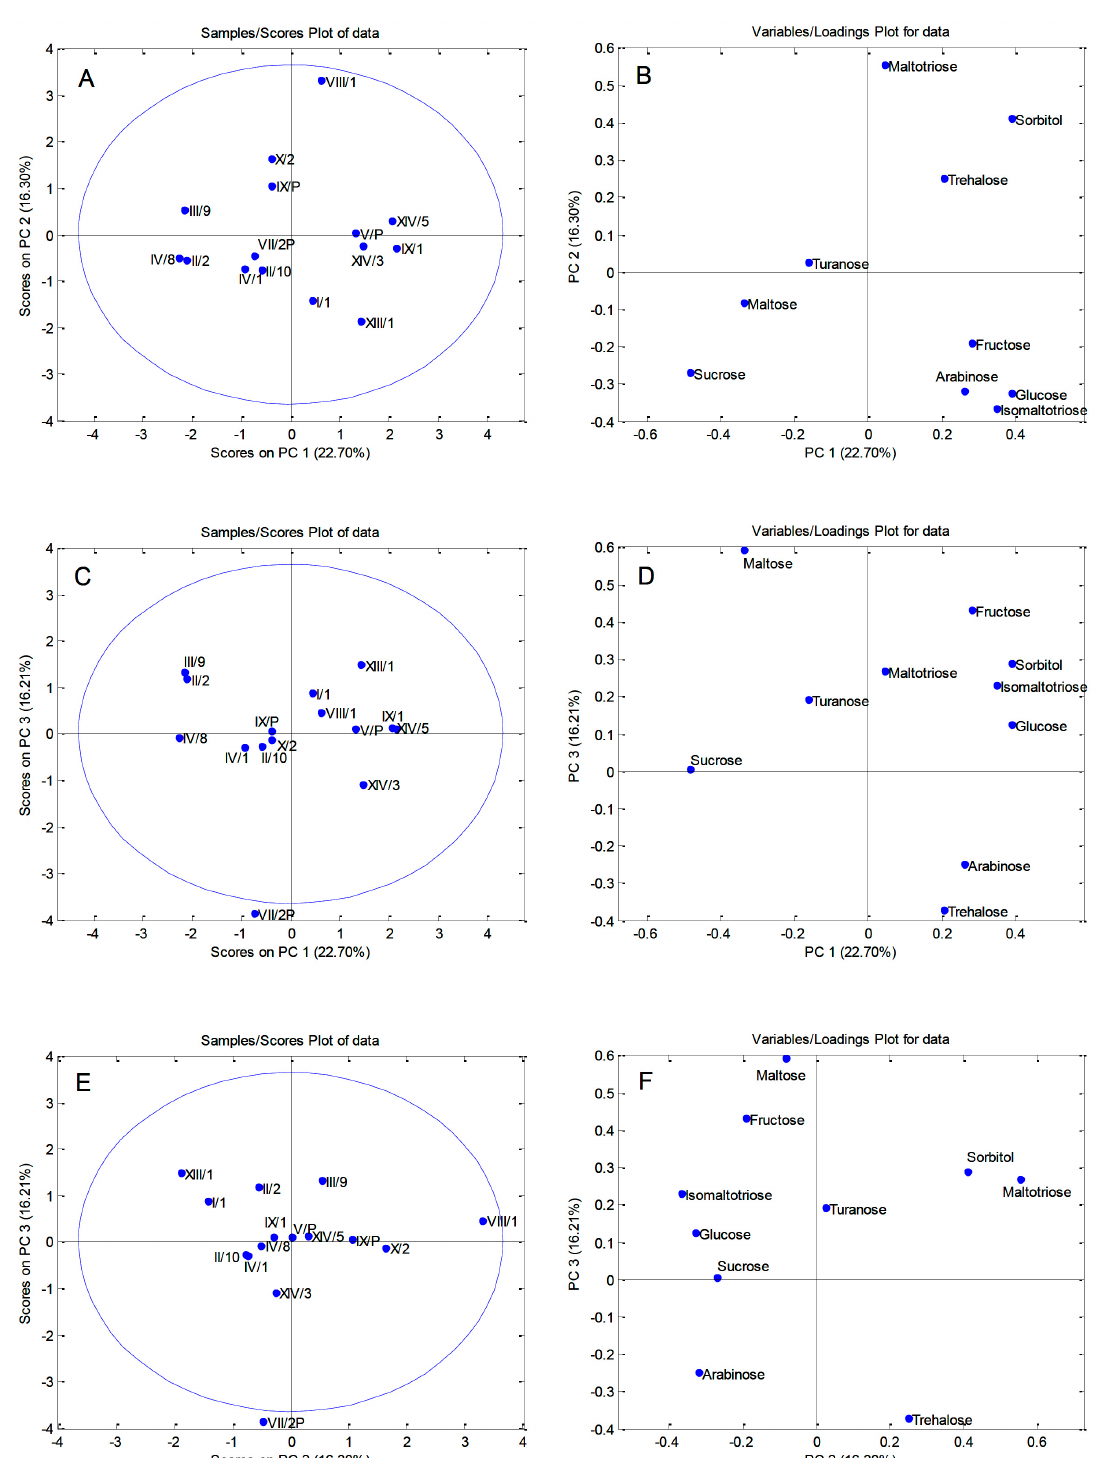
Figure 2. Principal component analysis (PCA) performed on sugar contents in pollen samples of ‘Oblaˇcinska’ sour cherry clones: Scores plots of the first three principal components ( A , C , E ) and loadings plots ( B , D , F ).